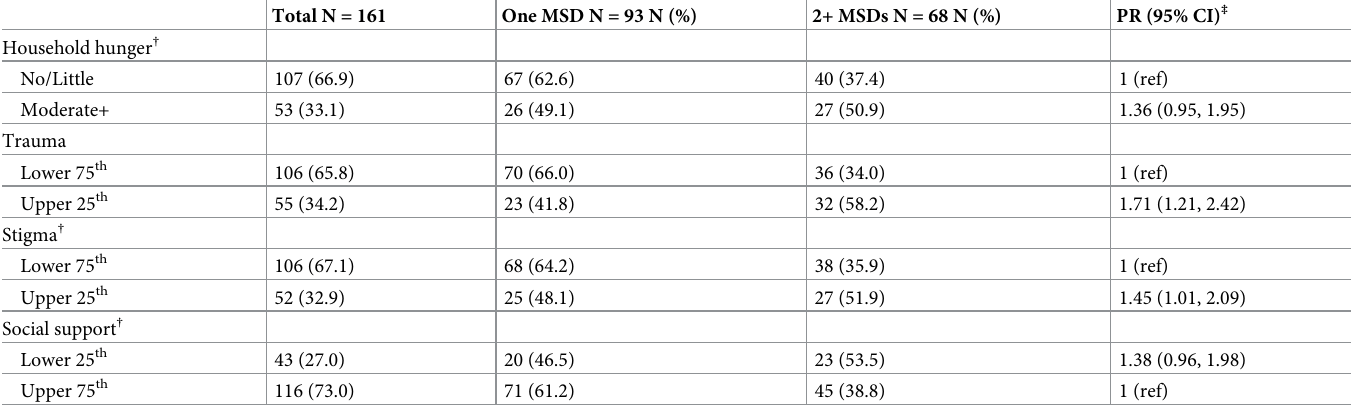
Table 3. Psychosocial stressors and psychiatric comorbidity among PWH with symptoms of depression, anxiety, post-traumatic stress disorder, or harmful alcohol use who are initiating HIV care in Cameroon. Total N = 161 One MSD N = 93 N (%) 2+ MSDs N = 68 N (%) PR (95% CI)